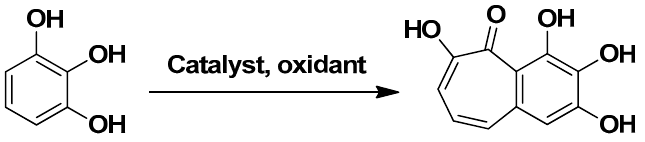
Scheme 7. General scheme of 1,2,3-trihydroxybenzene oxidation.